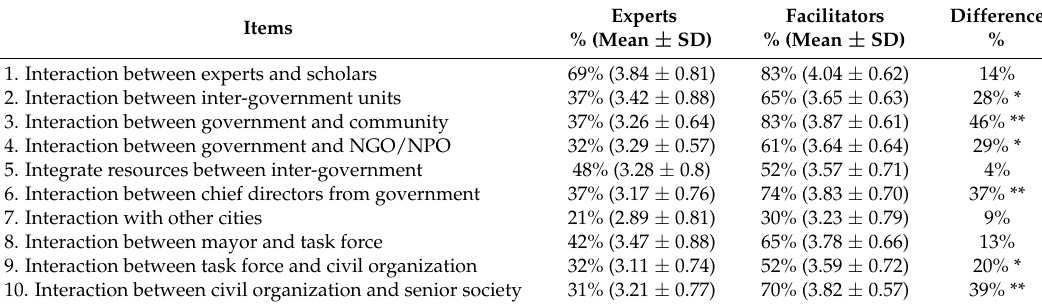
Table 3. Integration of resource ratings by experts and